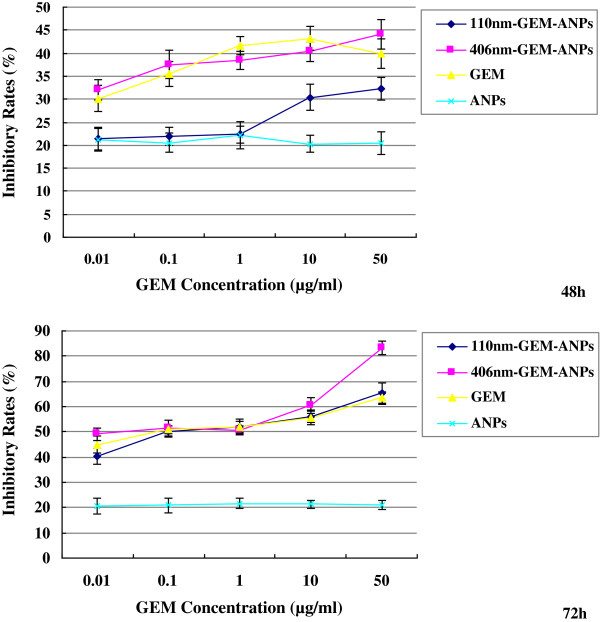
Inhibition rate. Gemcitabine concentration profile of 406-nm GEM-ANPs, 110-nm GEM-ANPs, gemcitabine, and ANPs on the human pancreatic cancer cell line PANC-1 after exposure for 48 and 72 h in vitro.